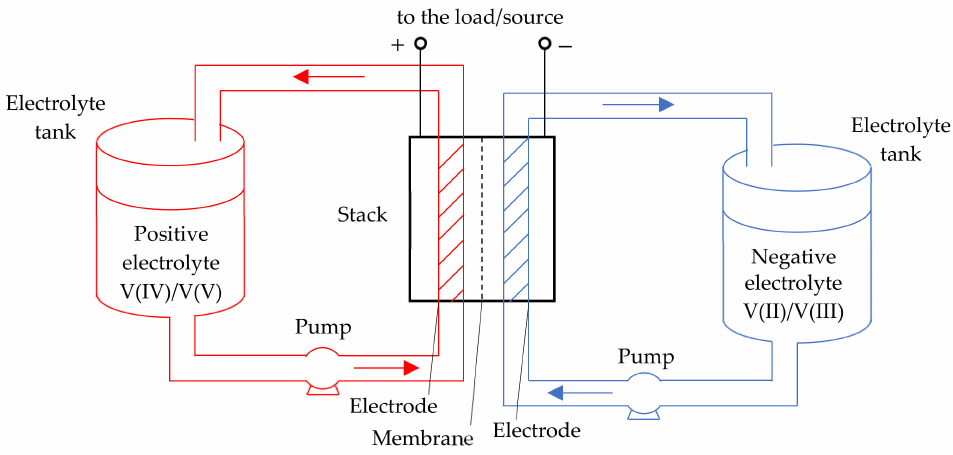
Figure 1. Circuit diagram of the VRB